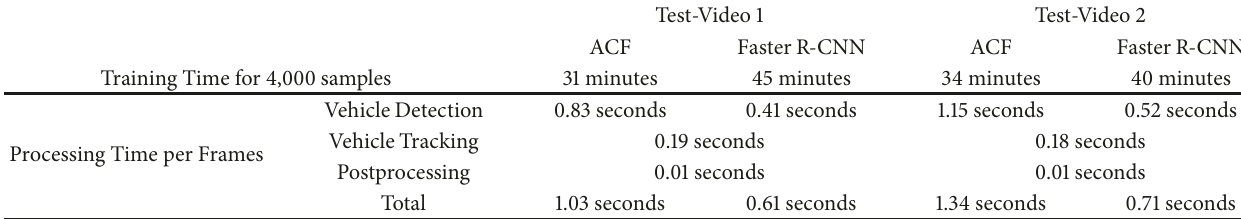
Table 4: Computation time of detection, tracking, and postprocessing.